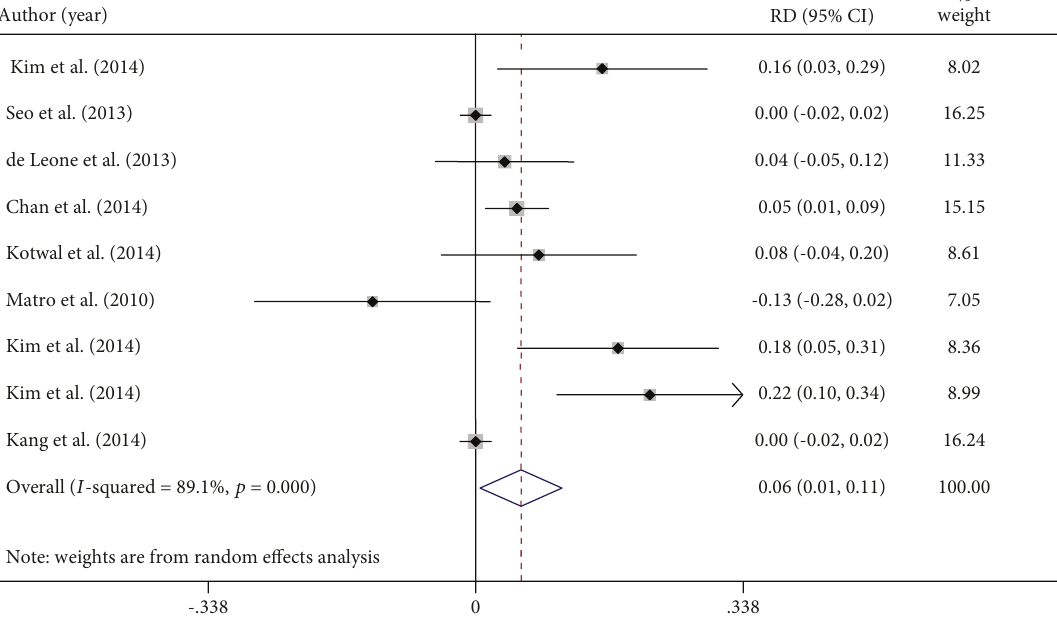
Figure 4: Percentage di ff erence (expressed as rate di ff erence, RD) of compliance of patients consuming same-day or split bowel preparation. RD =rate di ff